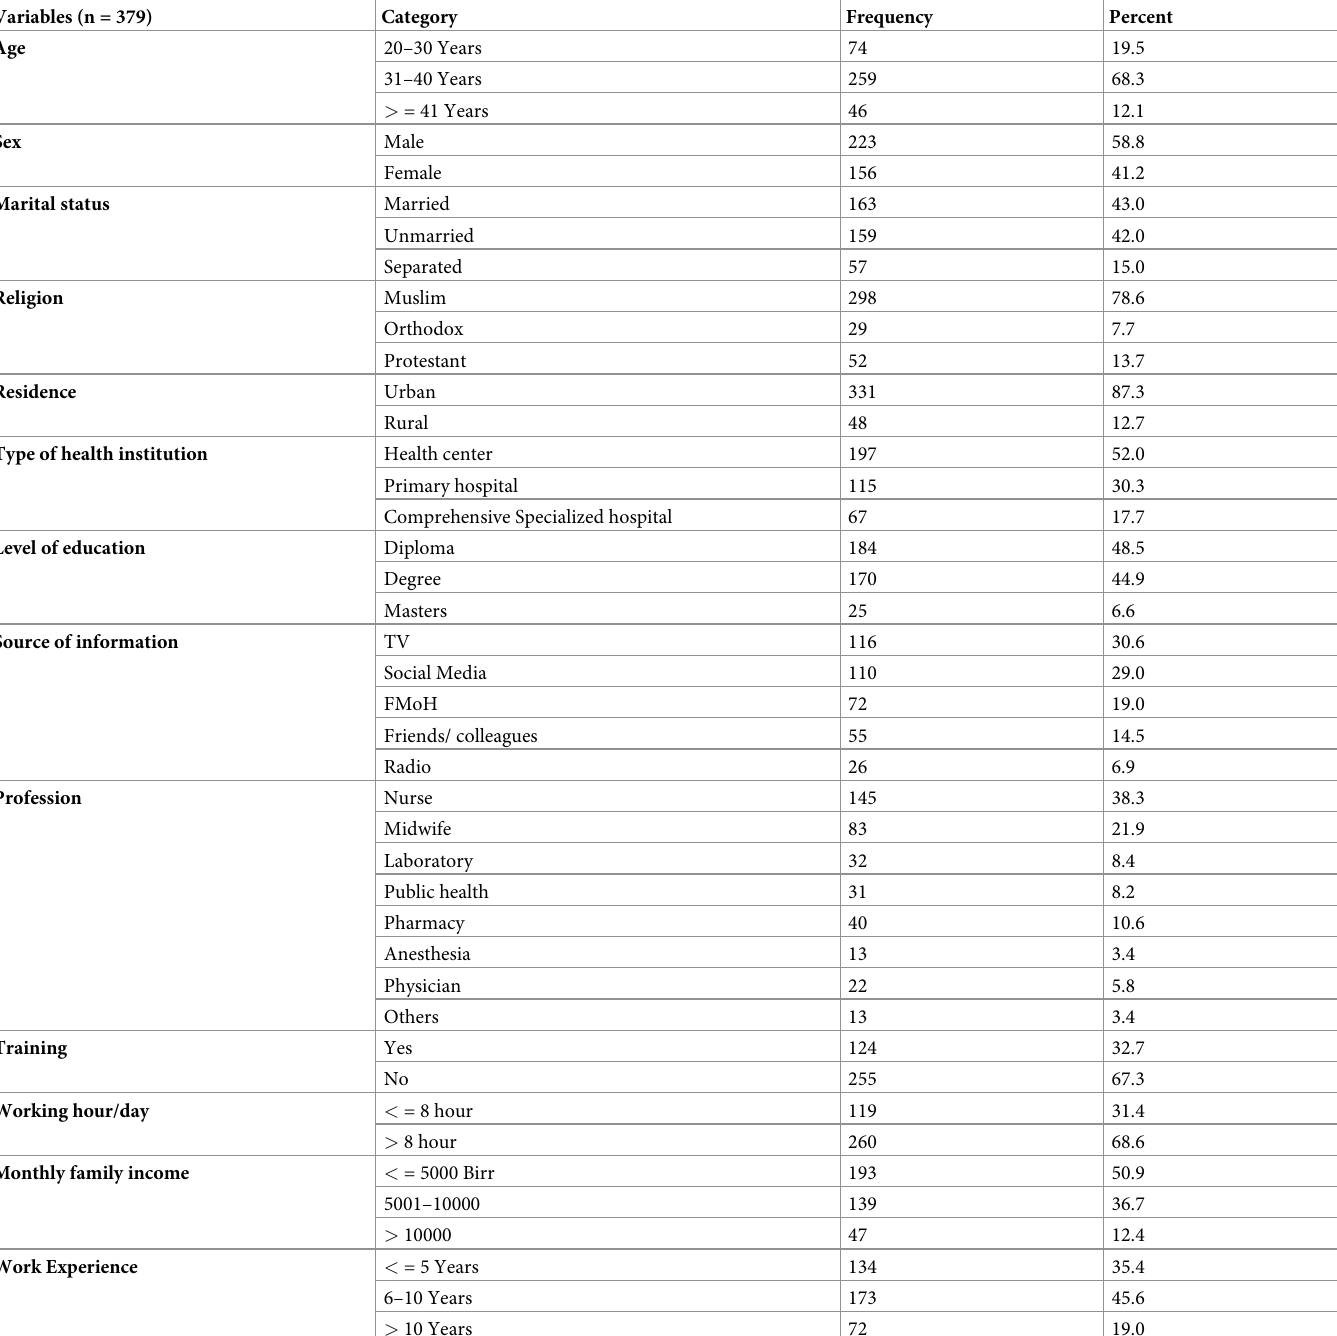
Table 1. Socioeconomic and demographic characteristics of the study participants, Silte zone, southern Ethiopia, 2020. Variables (n =